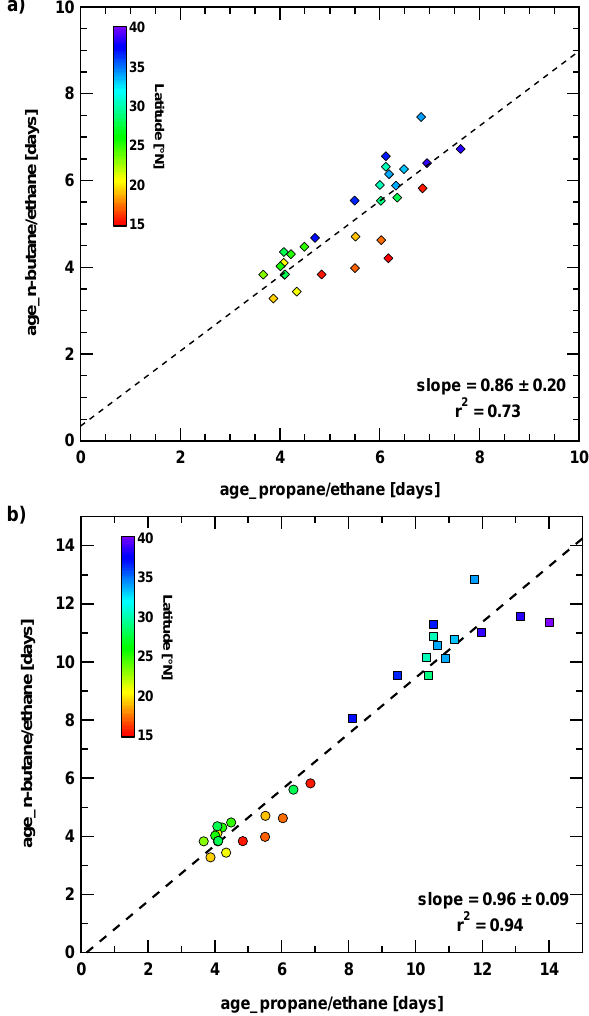
Fig. 8. Comparison between ages determined from n-butane/ethane and propane/ethane (a) assuming the same h [OH] i in both the north and the south and (b) using different h [OH] i for northern (squares) and southern (circles) regimes. The dashed line represents the linear fit to the data, with uncertainties representing the 95% confidence interval. Points are color-coded by sampling location